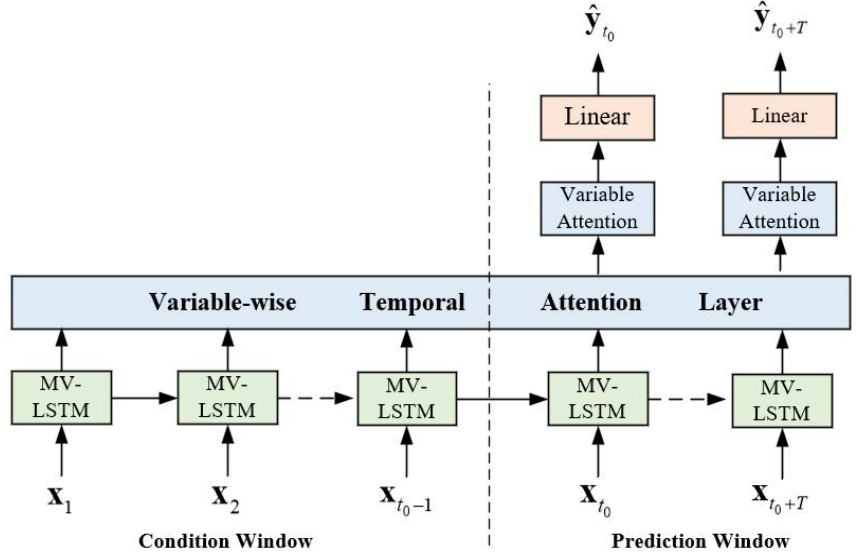
Figure 2. The encoder–decoder network architecture based on MV-LSTM and mixture attention